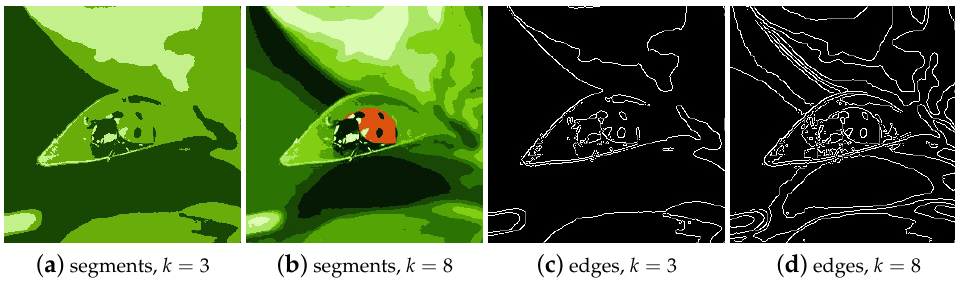
Figure 3. Edge detection by the k-Means algorithm. The upper row: k-Means segmentation for ( a ) k = 3, ( b ) k = 8 segments. The lower row: the edges of k-Means segmentation for ( c ) k = 3, ( d ) k = 8